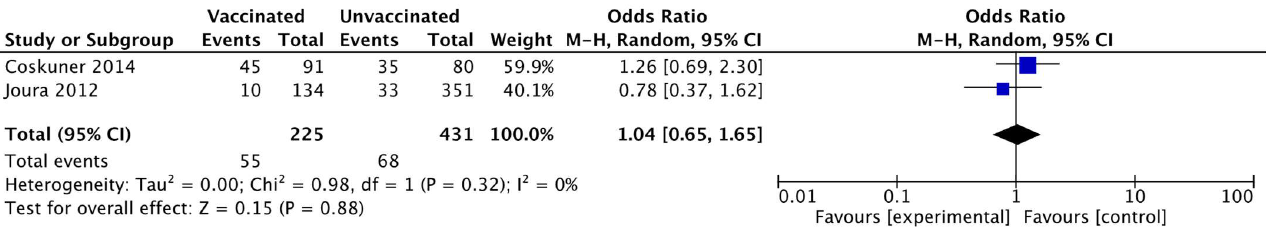
Figure 8. Forest plot of comparison: AGWs recurrence.